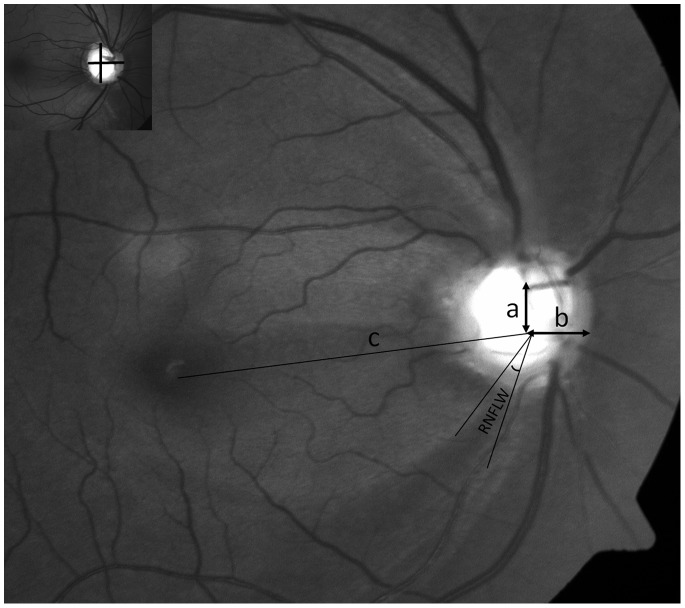
Parameters obtained from the red free fundus photograph.Reference line “c” is a line from the center of the optic disc to the center of the macula. The vertical distance of the central vessel trunk “a” and horizontal distance “b” was measured from the reference line and retinal nerve fibre layer width (RNFLW) using Image J software. Inset shows the division of the disc by two lines into 4 quadrants for determining the exit quadrant of the central vessel trunk.